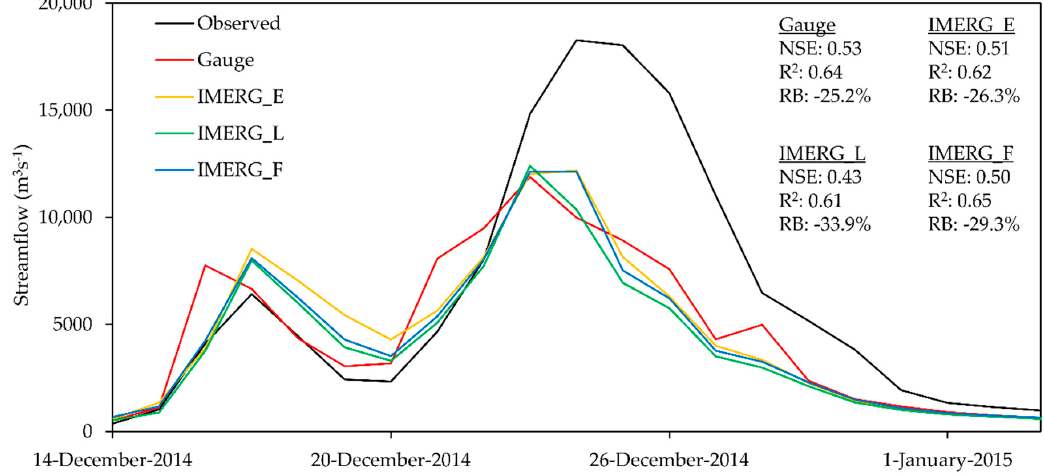
Figure 9. Daily SWAT streamflow simulations during the 2014–2015 flood by gauge and three GPM IMERG products at the Jambatan Guillermard.